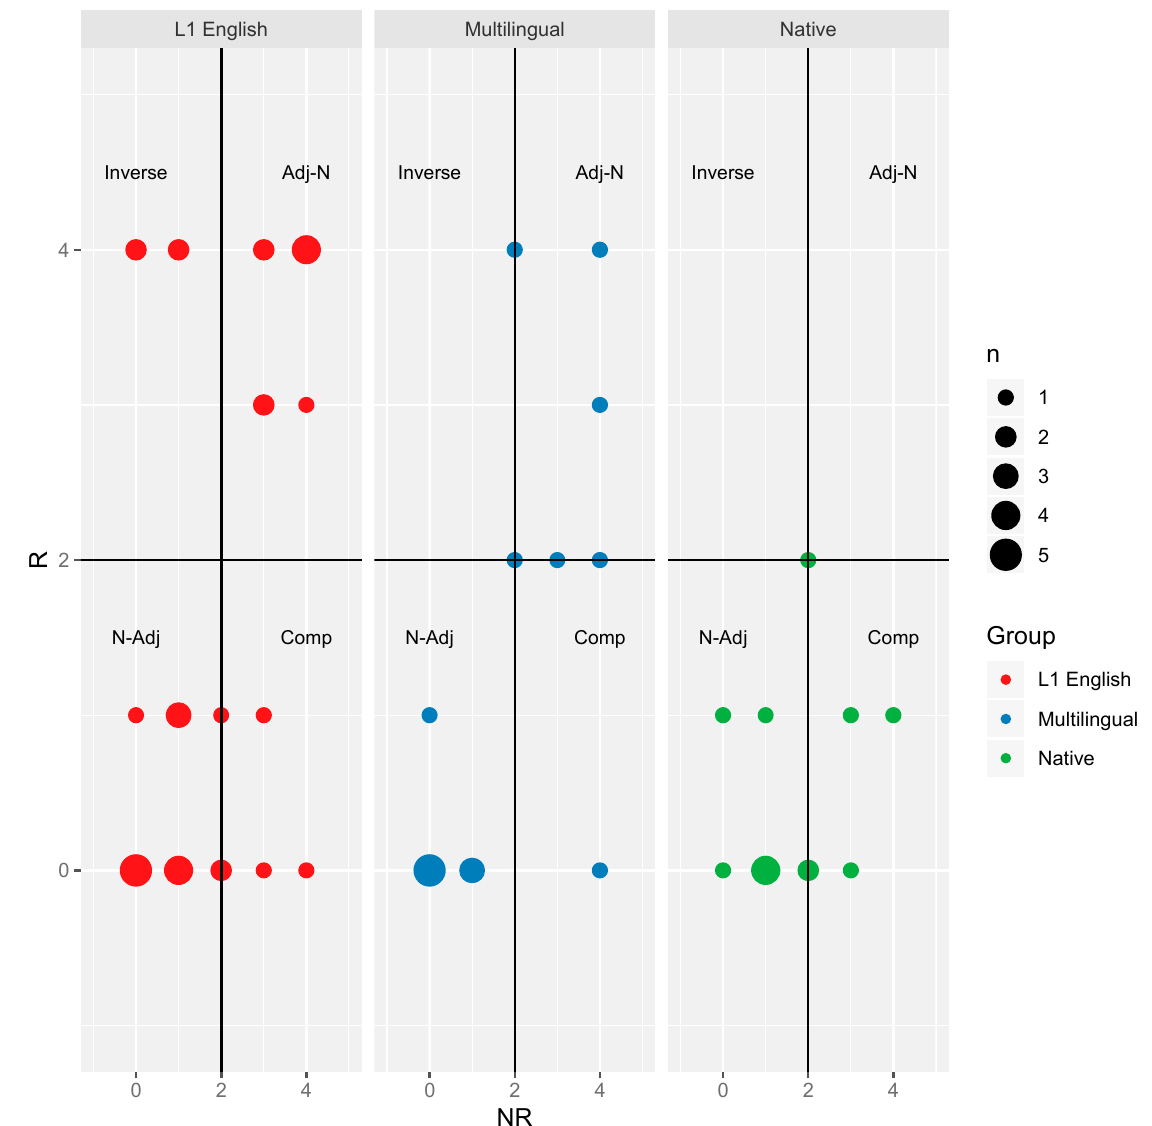
Figure 2. Counts of individual speakers plotted by number of Adj–N choices given the R condition and the NR condition (Inverse, Adj–N dominant, N–Adj dominant, Comp(lementary)).